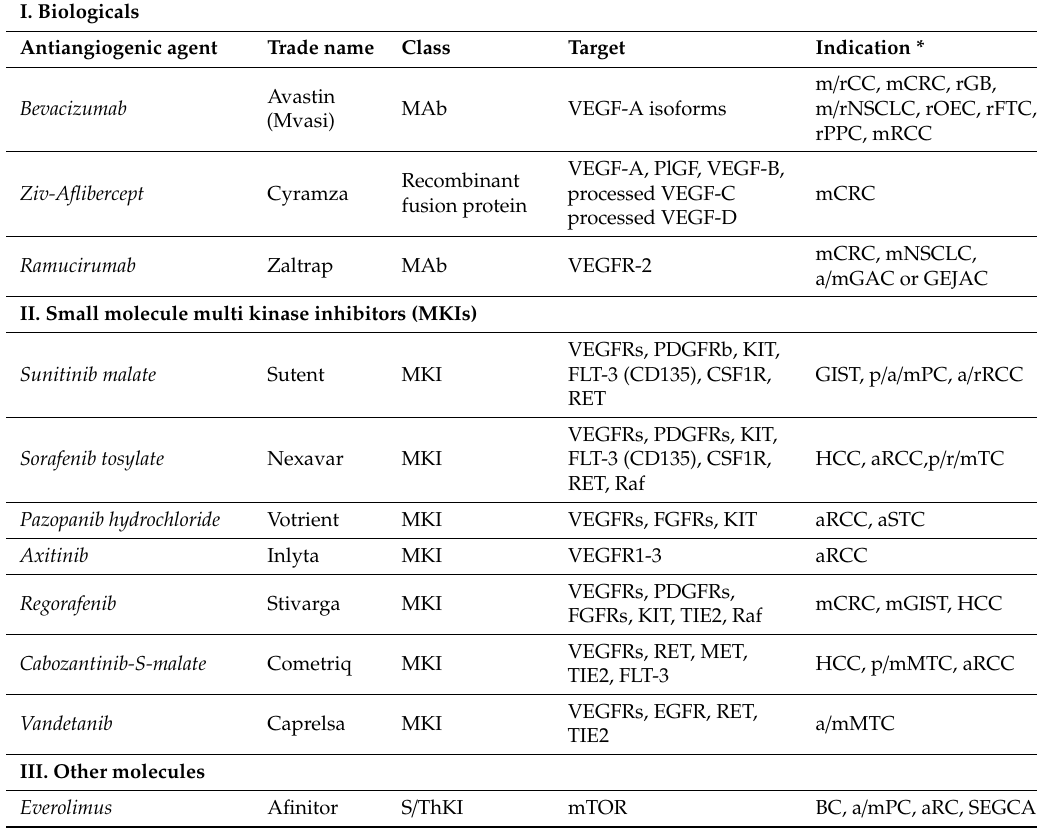
Table 1. Approved angiogenesis inhibitors for treatment of human cancer patients